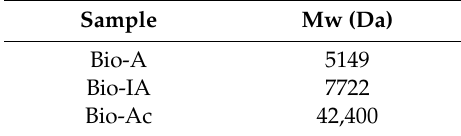
Table 3. MW data acquired for biomass intermediates and biopolymers.